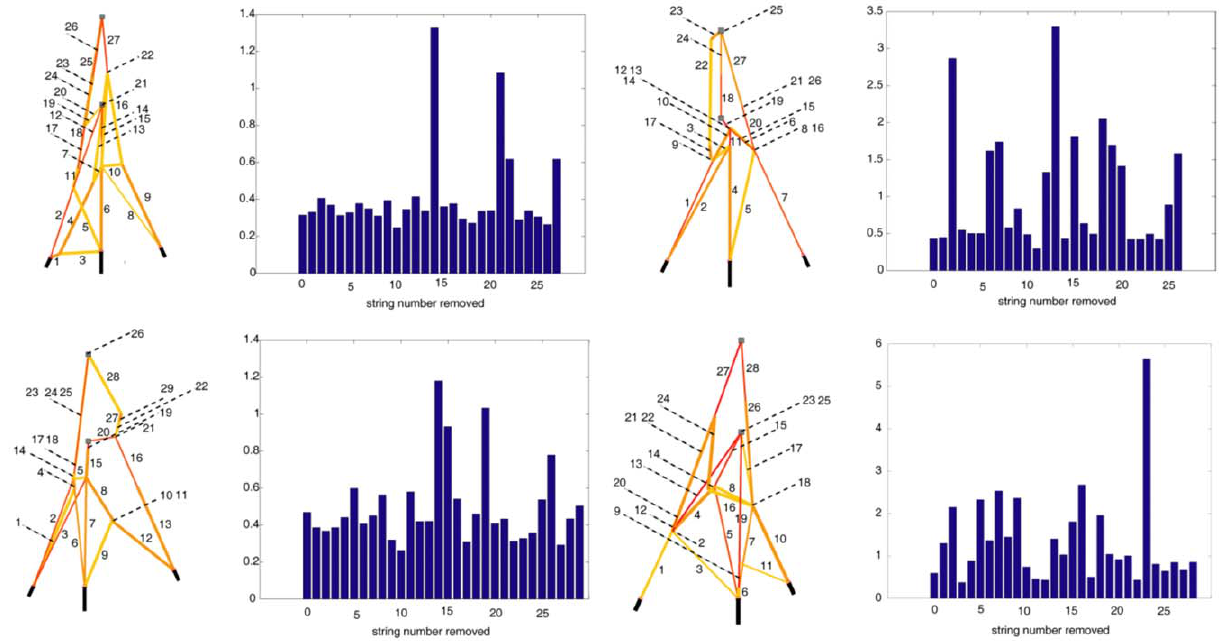
Figure 8. Additional information to accurately decipher the structural constitution of a finger extensor network is critical. First and third columns: Best models are evolved with linear elastic tendon properties (E=1 GPa). The models should emulate the informative experimental data from the cadaver hand. String numbers shown with the evolved networks. Second and fourth columns: Cross validation errors ( 6 100 for percentage) for corresponding models on the left. The first bar represents the error when the corresponding network on the left is intact. The following bars depict the error when the strings are snapped one at a time. The errors for the intact models are equal to or greater than 30%. From each model, elimination of certain strings lowers the cross validation errors suggesting that the intact models do not depict the functionality of the actual extensor mechanism accurately. If erroneous postulations are employed, the experimental data obtained by the inference process may not be informative after all.